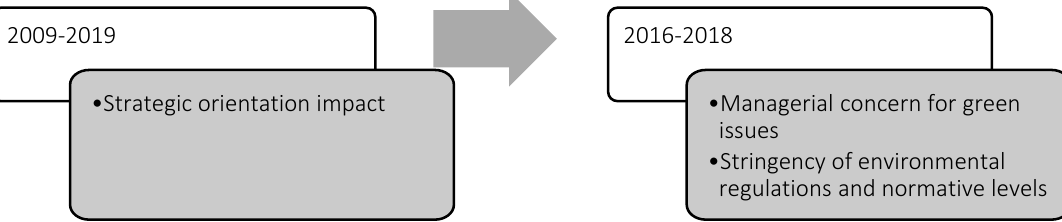
Figure 1. Trends in the development of conventional innovation research